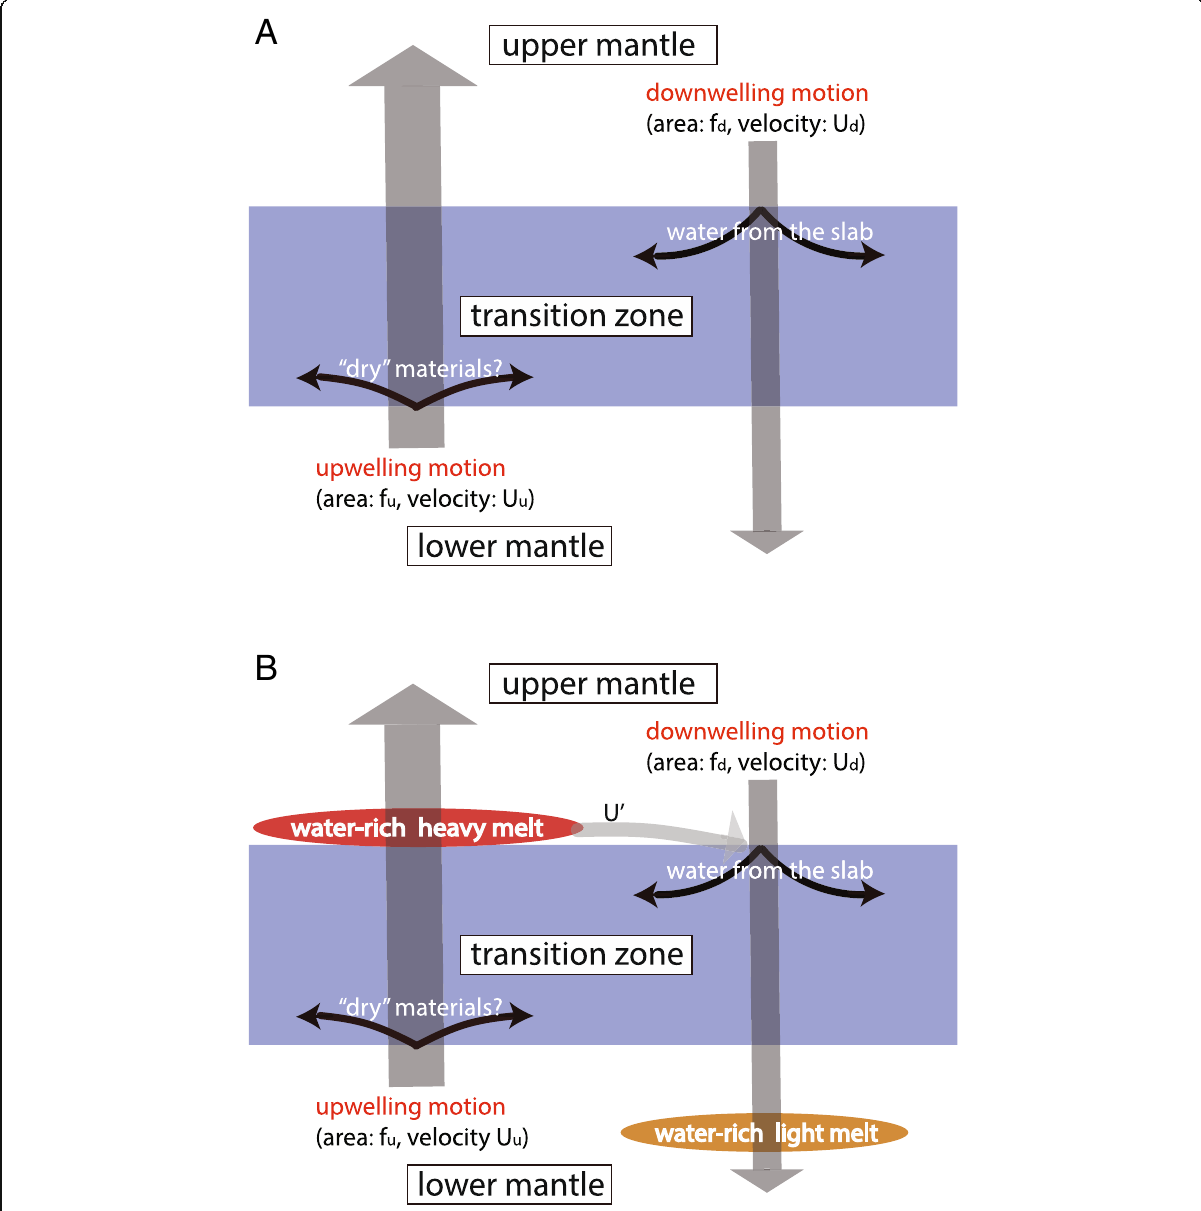
Fig. 8 A model of water transport across the mantle transition zone. a A model without melting f u : area fraction of upwelling, f d : area fraction of down-welling, U u : velocity of upwelling, U d : velocity of down-welling. From the mass conservation, f u U u ¼ f d U d ≡ 1 In this model, we assume that melts formed above the MTZ are heavy and the melts formed below the MTZ are light. U ′ the velocity of migration of the MRL materials from upwelling regions to the subduction zones (this depends on mantle viscosity and is fast only above 410